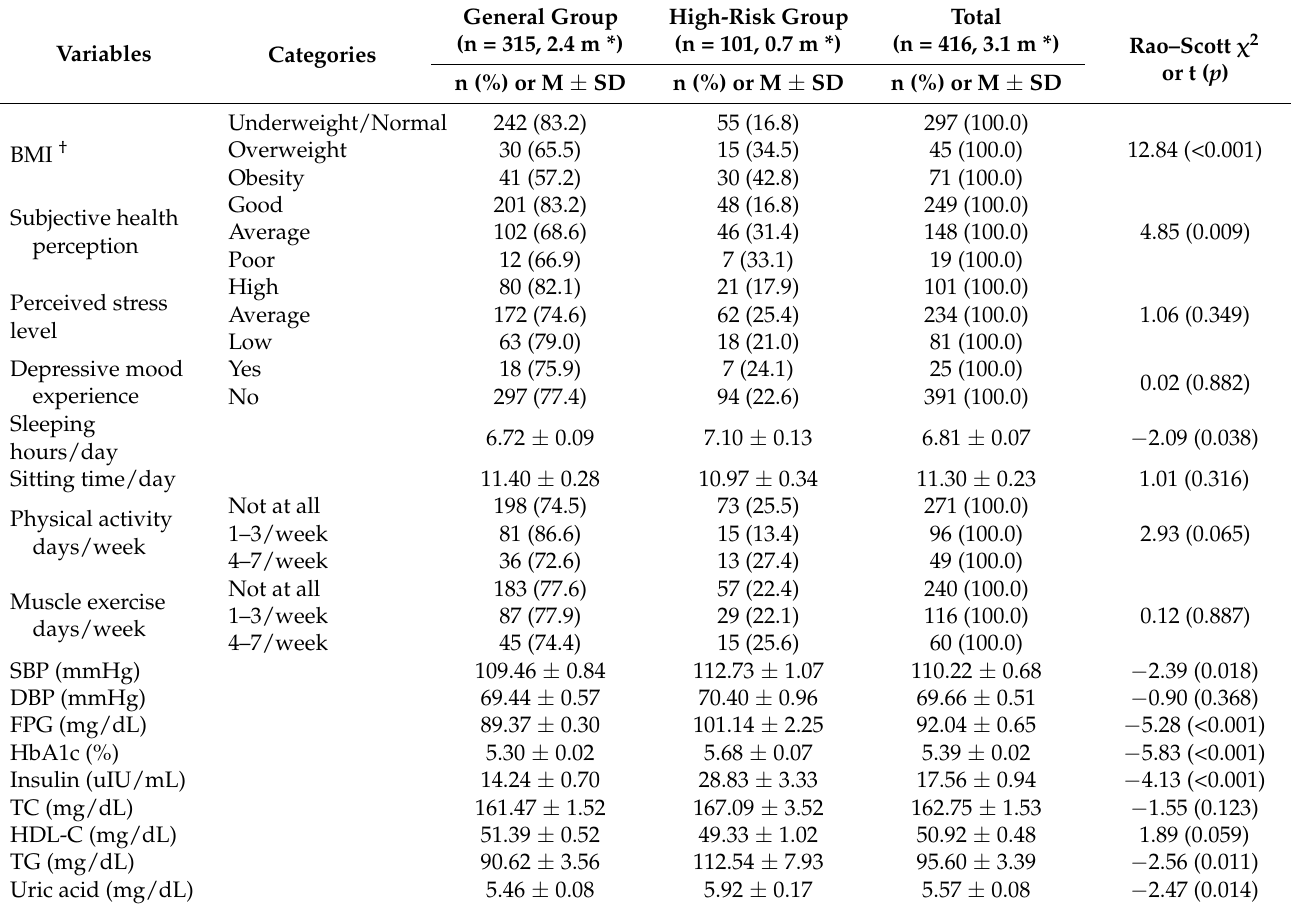
Table 2. Comparison of Physiological and Biochemical Indicators in General and High-Risk Groups for Diabetes among Adolescents ( N =